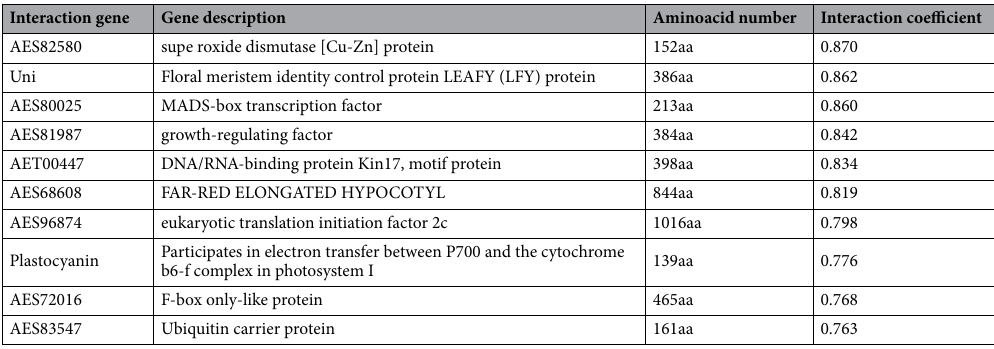
Table 2. MsSPL functional protein-protein